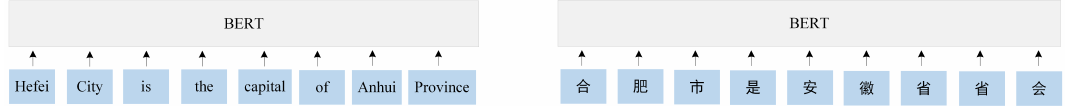
Figure 1. The difference between Chinese and English sentences when inputted into Bidirectional Encoder Representations from Transformers